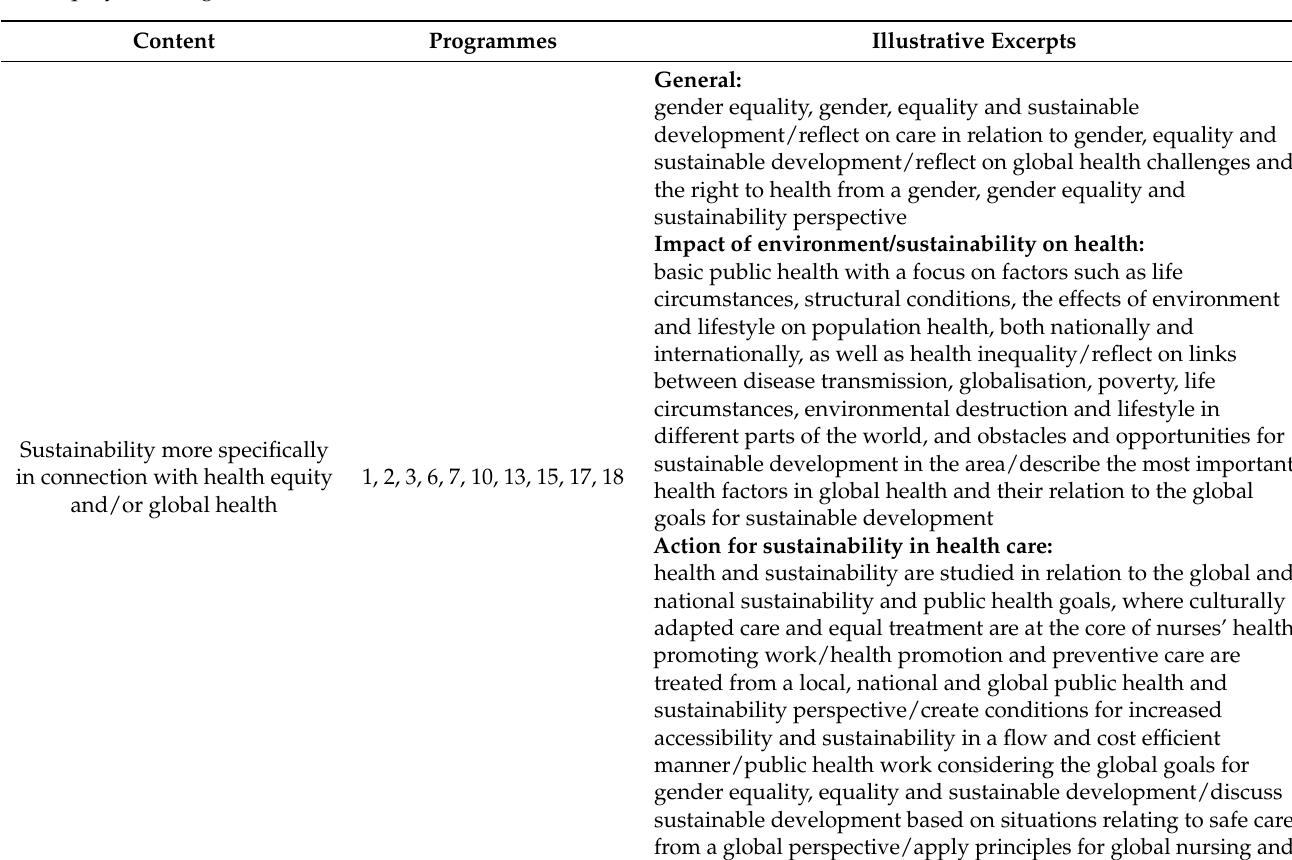
Table 9. Overview of sustainability and environmental content in the syllabi, more specifically in connection with health equity and/or global